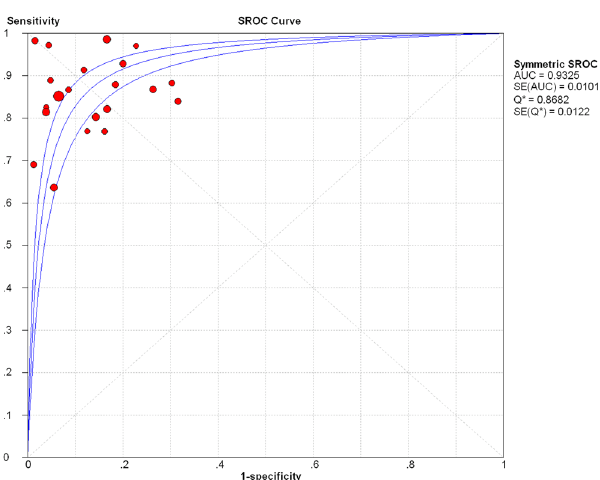
Figure 4. The sROC plane for heterogeneity test of threshold effect of each independent study. The sROC (middle line) with 95% CI (the other two lines) of MRI in diagnosing of ACL injury. sROC: summary receiver operator characteristic; CI: confidence interval; AUC: area under the curve; Q * : Q index value; SE: standard